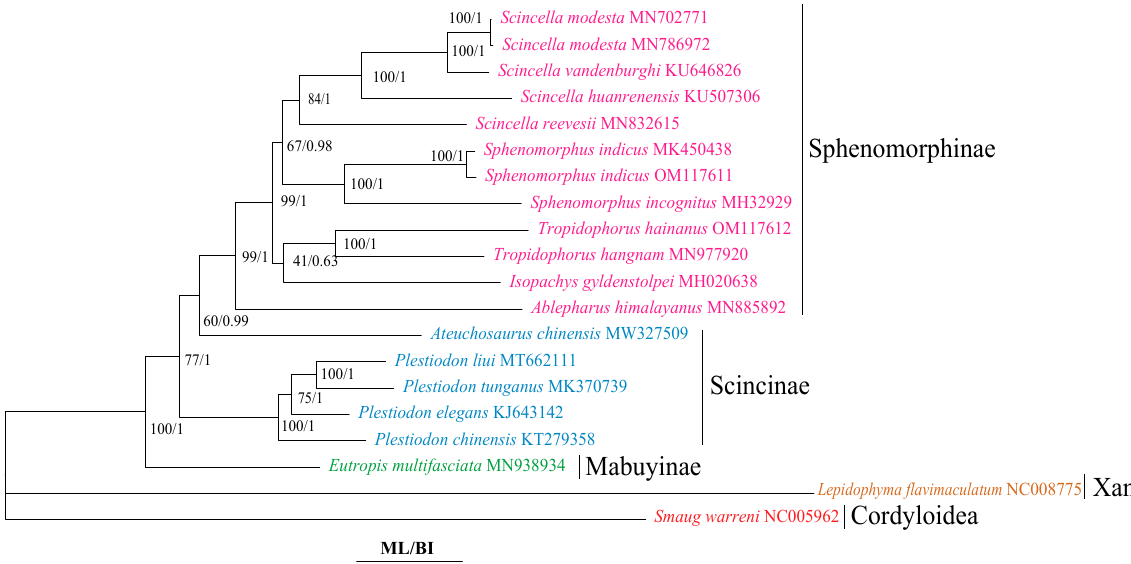
Figure 3. Phylogenetic relationships among 18 species of Scincidae based on the nucleotide dataset of the 13 mitochondrial protein-coding genes. Smaug warreni and Lepidophyma flavimaculatum were used as the outgroups. The numbers above the branches specify bootstrap percentages from ML (left) and posterior probabilities as determined from BI (right). The GenBank accession numbers of all species are shown in the figure. Different colors represent different subfamilies.